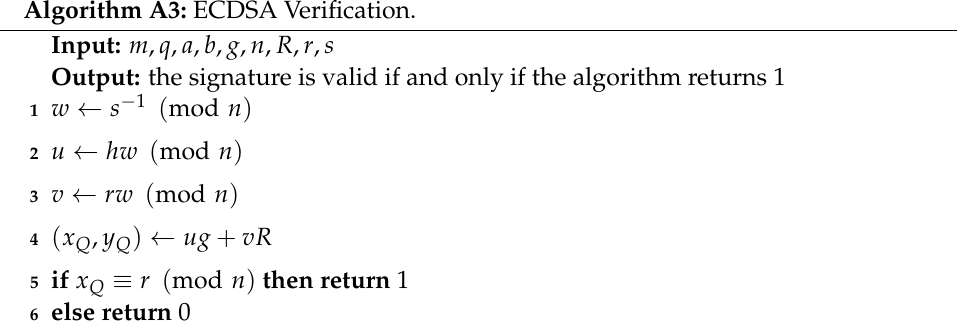
Algorithm A3: ECDSA